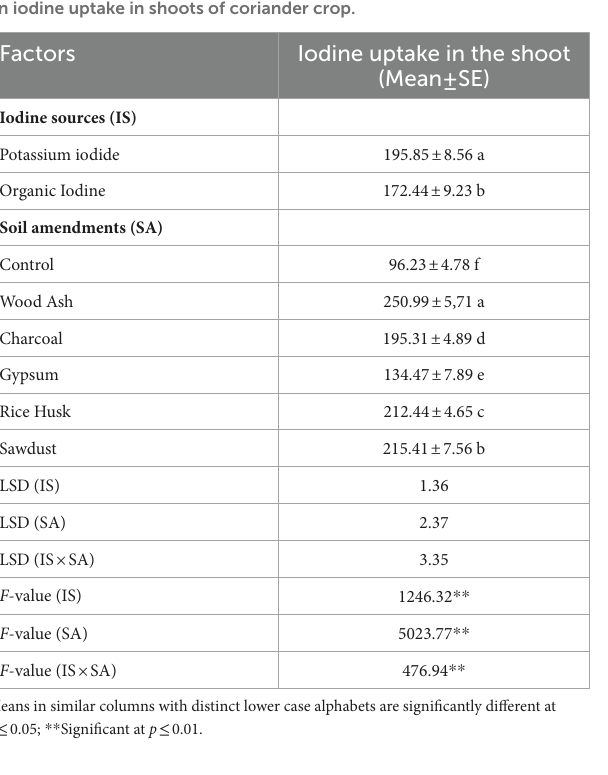
TABLE 4 Effect of different iodine sources (IS) and soil amendments (SA) on iodine uptake in shoots of coriander crop.